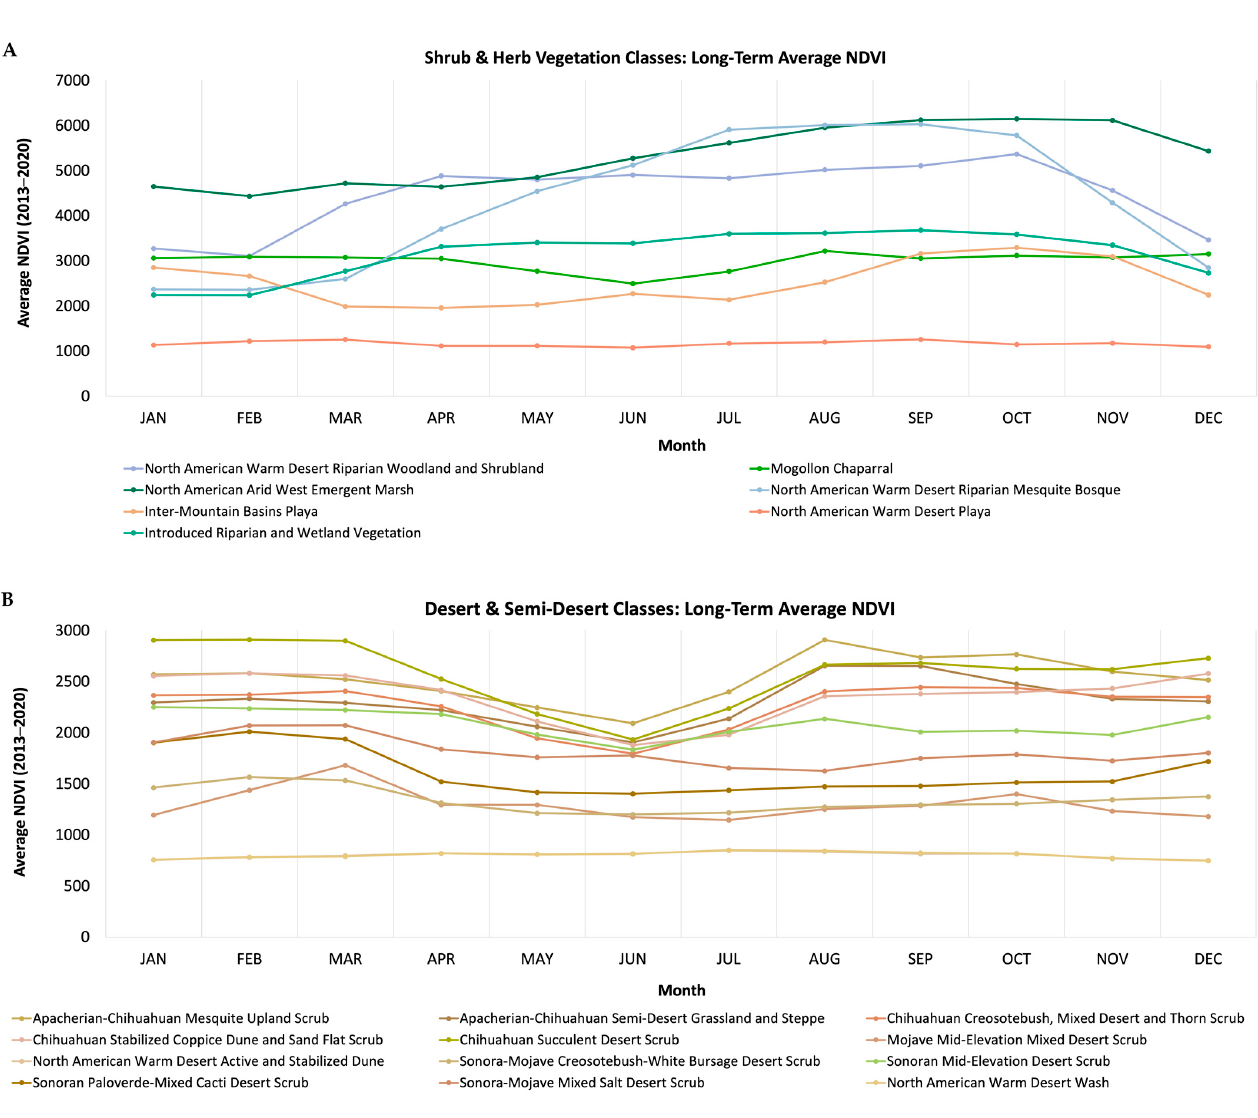
Figure 9. Long-term annual average NDVI time series from 2013 to 2020 for ( A ) shrub and herb vegetation classes and ( B ) desert and semi-desert classes.